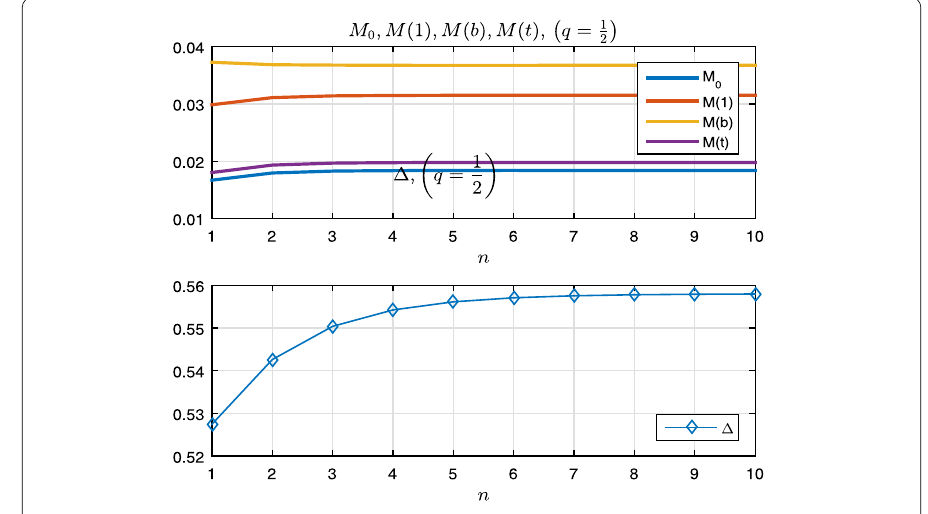
Figure 8 2D graphs of M 0 , M (1), M ( b ), M ( t ) on t ∈ J for q = 1